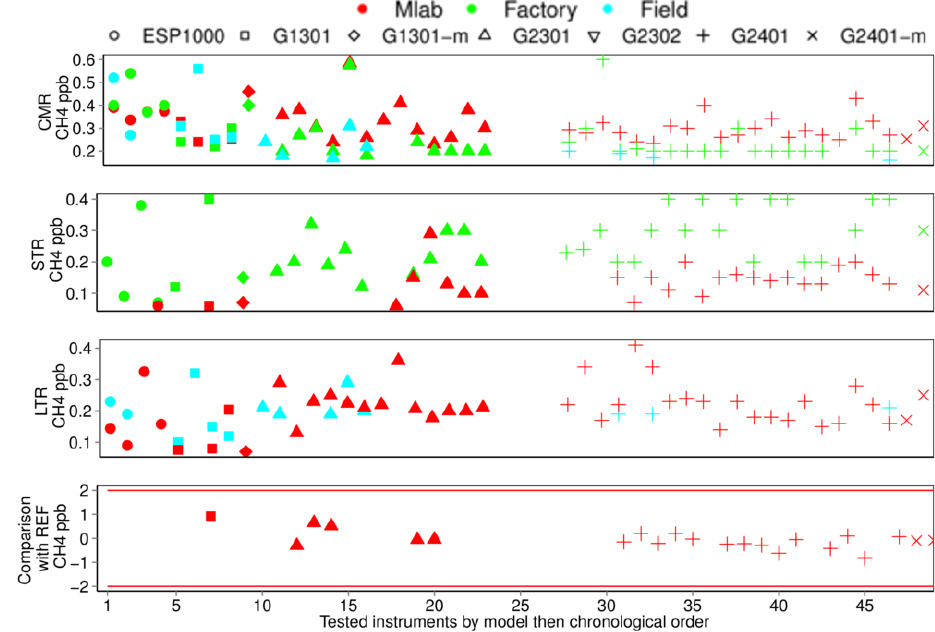
Figure 4. Results for CH 4 . First panel: continuous measurement repeatability (CMR) at the factory (as defined), at the MLab (on the raw data) and in the field (as defined). Second panel: short-term repeatability (STR) at the factory and the MLab. Third panel: long-term repeatability (LTR) at the MLab and in the field. Fourth panel: comparison with reference instrument, average difference at the MLab. The horizontal lines show the WMO compatibility